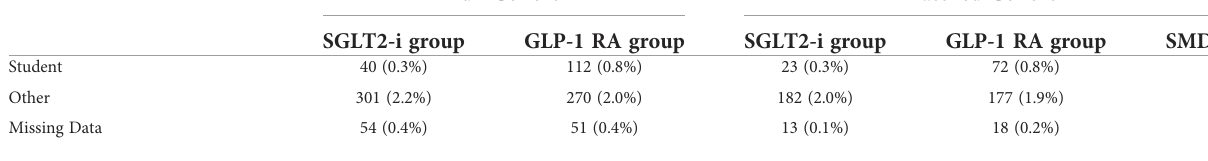
TABLE 2 Hazard Ratios (HR) for various fracture types in the matched cohort. Fracture